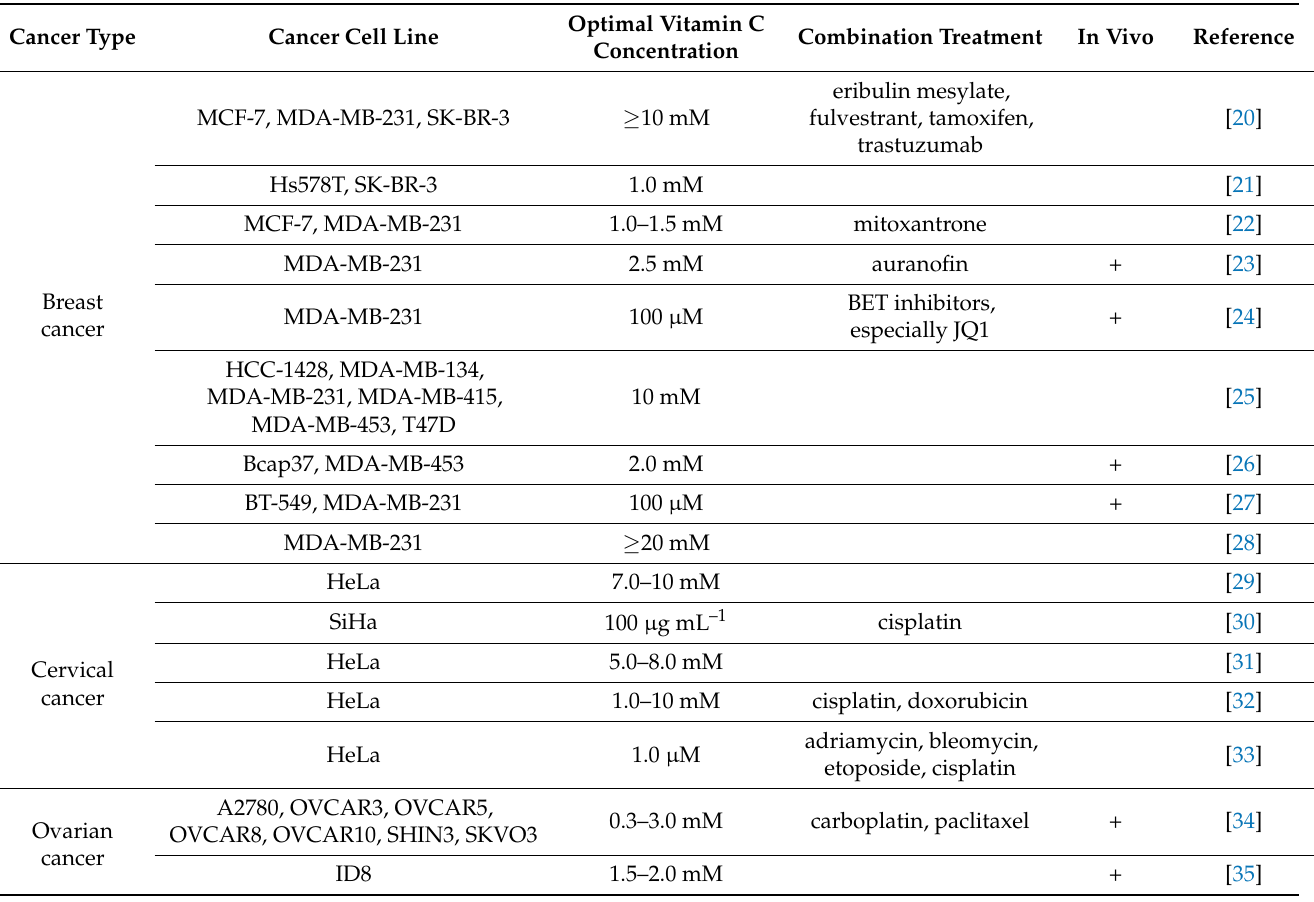
Table 1. In vitro (and animal) studies with vitamin C on cancer cell